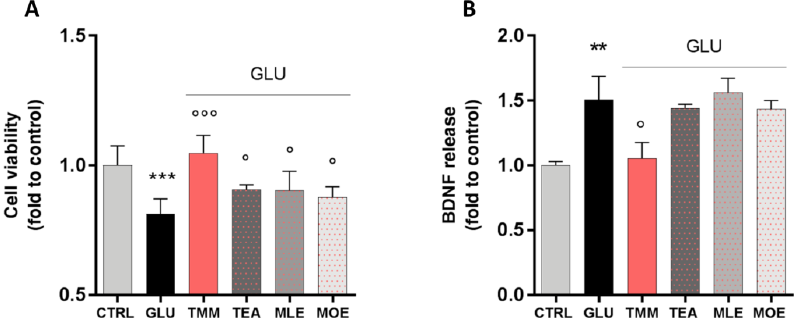
Figure 5. Neuroprotective effect induced by TMM in L-glutamate (GLU)-stimulated SH-SY5Y cells compared to TEA, MLE, and MOE ( A ). Modulation of brain-derived neurotrophic factor (BDNF) release after GLU stimulation by TMM, TEA, MLE, and MOE ( B ). *** p < 0.001, ** p < 0.01 vs. CTRL; °°° p < 0.001, ° p < 0.05 vs. GLU.